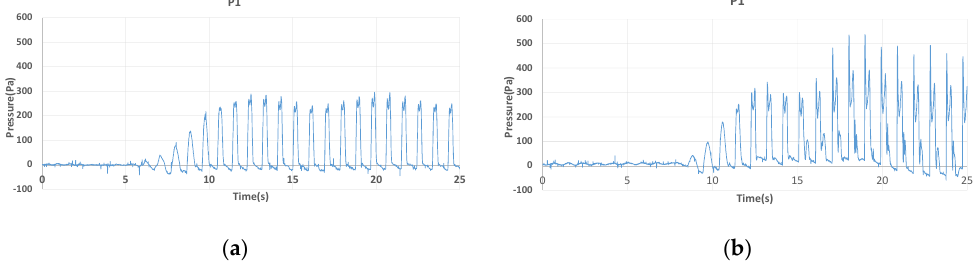
Figure 4. Measured pressure at P1 with a filling ratio of 25% for ( a ) sway and ( b ) roll motions.